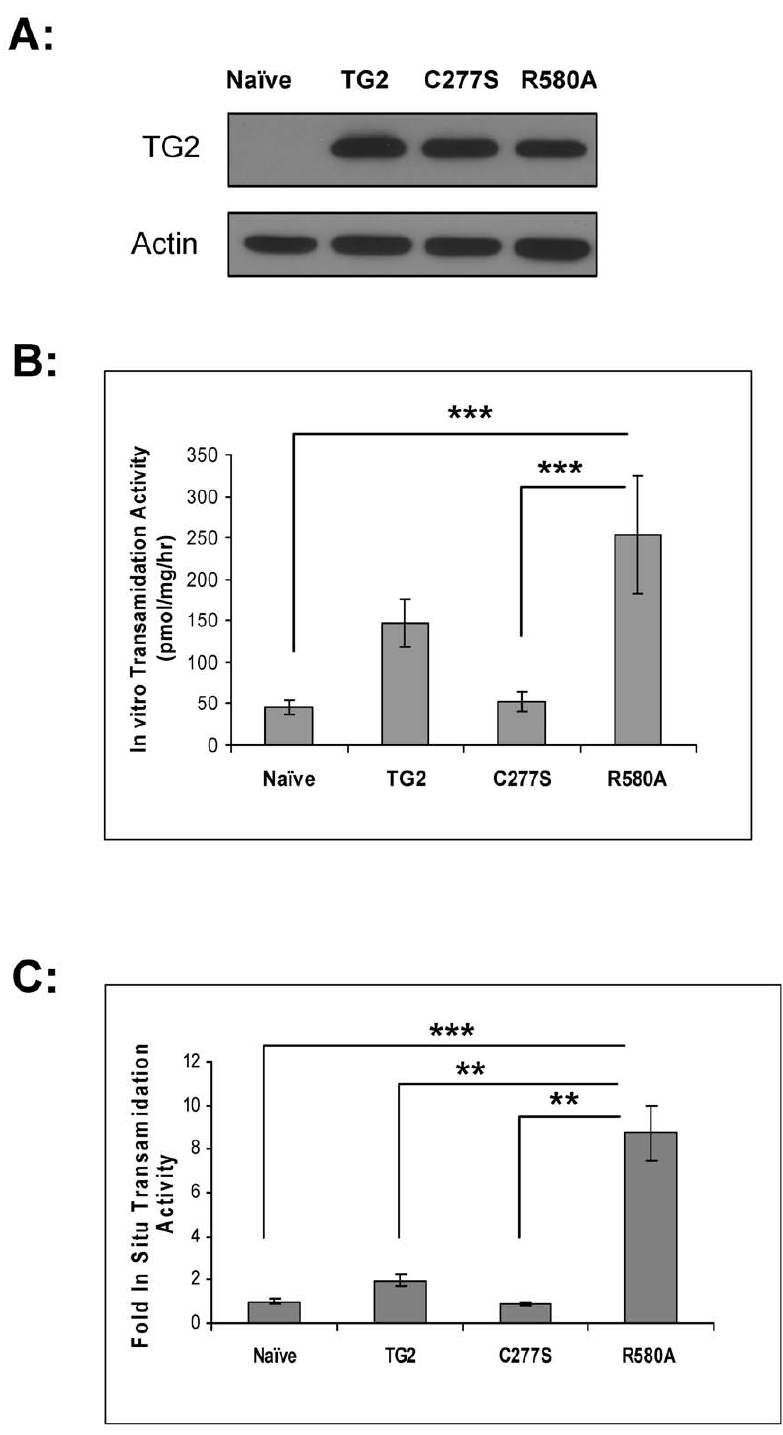
Figure 1. Characterization of striatal stable cell lines. A , Representative immunoblots of cell lysates from striatal cells stably expressing wild type TG2, TG2-C277S (C277S) or TG2-R580A (R580A) mutants. Top panel: Lysates were blotted for TG2. Bottom panel: Lysates were blotted for actin as loading control. B , In vitro transamidating activities of stable striatal cell lines. TG2-R580A cells show significantly greater in vitro transamidating activity compared to naı¨ve and C277S cells. (N=5) C , In situ transamidating activity of striatal stable cell lines. TG2-R580A (R580A) cells show significantly higher in situ transamidating activity than all the other cell lines. (N=3) Results are shown as mean + / 2 standard error, **p , 0.01, ***p , 0.005.